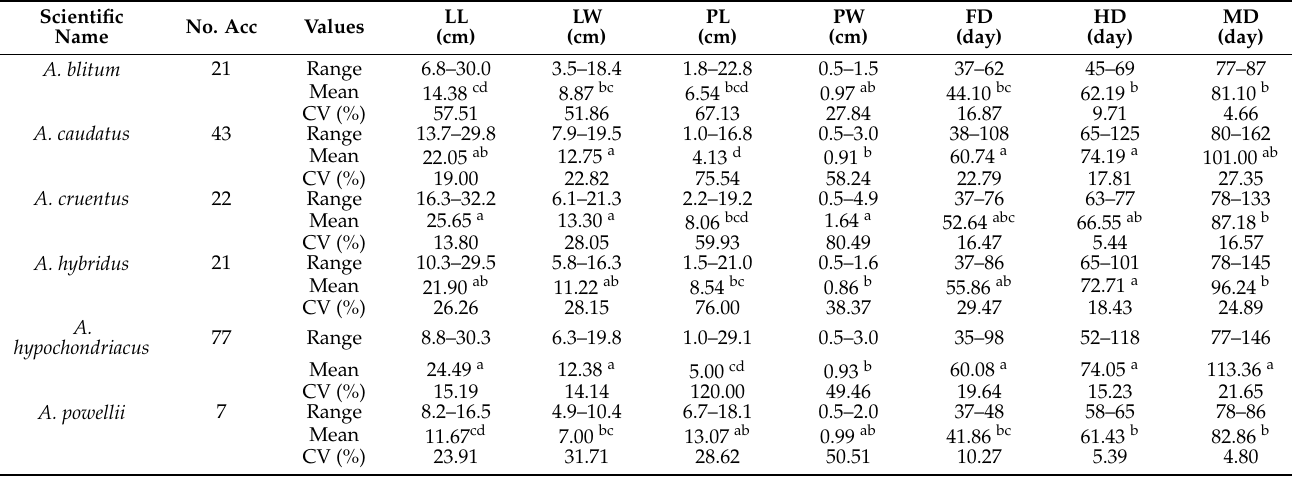
Table 2. Comparison of agricultural traits of nine Amaranthus species.